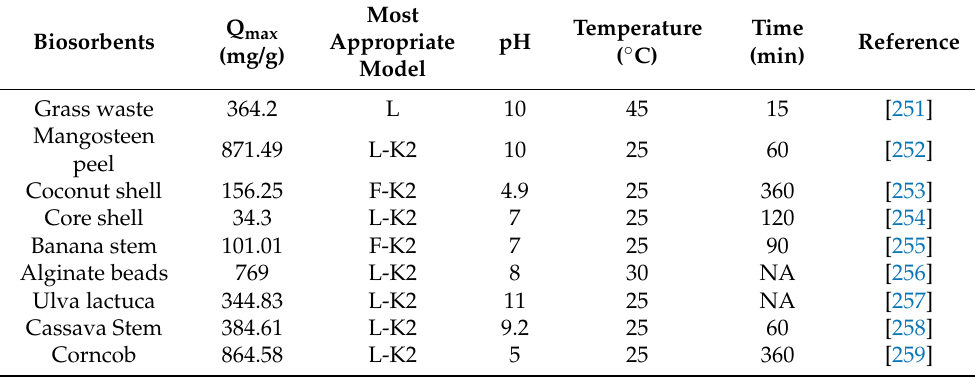
Table 13. Summary of bio-waste-derived adsorbent studies in